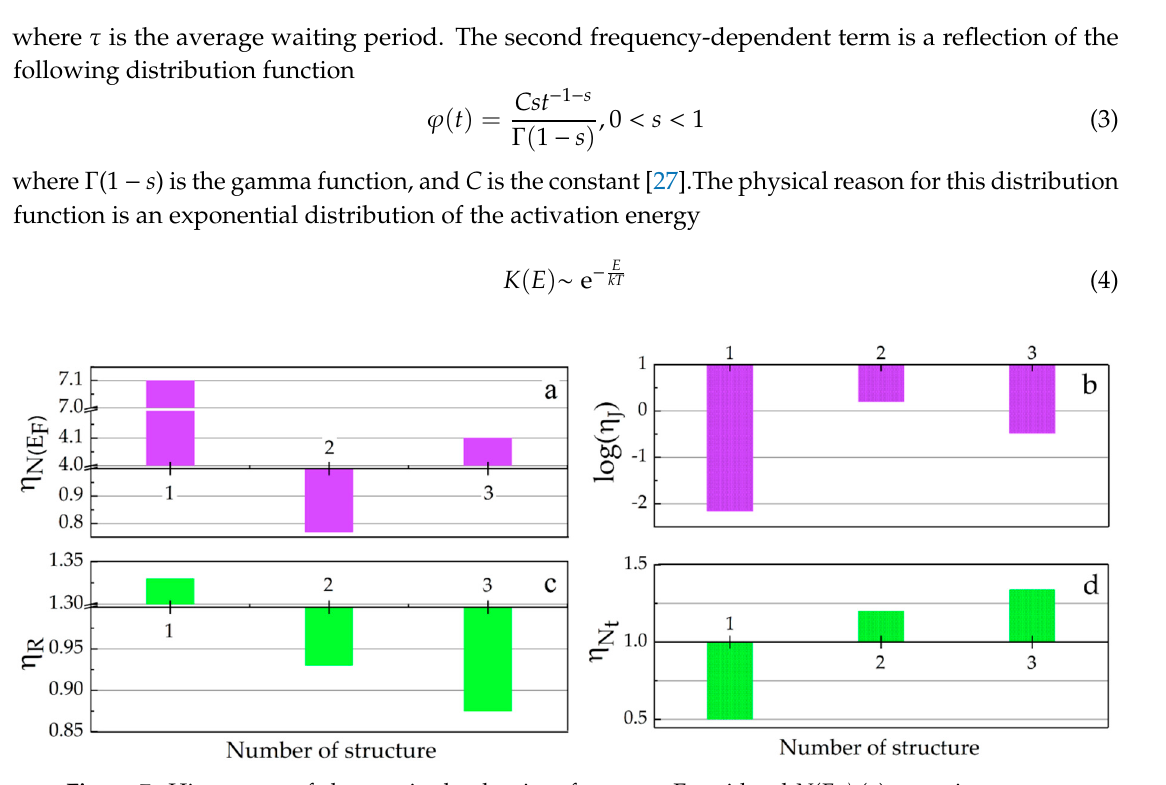
Figure 7. Histograms of changes in the density of states at Fermi level N(E F ) ( a ), trapping centres scattering J ( b ), hopping radius R ( c ) and density of deep trapping centres N t ( d ) relative to initial fourfold expanded GaSe matrix for GaSe(SC(NH 2 ) 2 ) (1), GaSe(SmCl 3 ) (2) and GaSe(SC(NH 2 ) 2 (SmCl 3 )) (3).